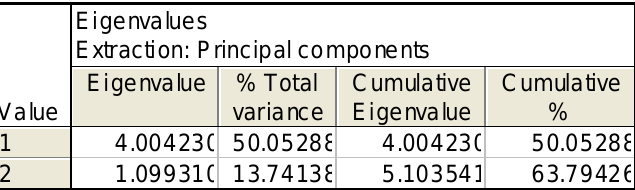
Table 3: Eigenvalues extracted from the Exploratory Factor